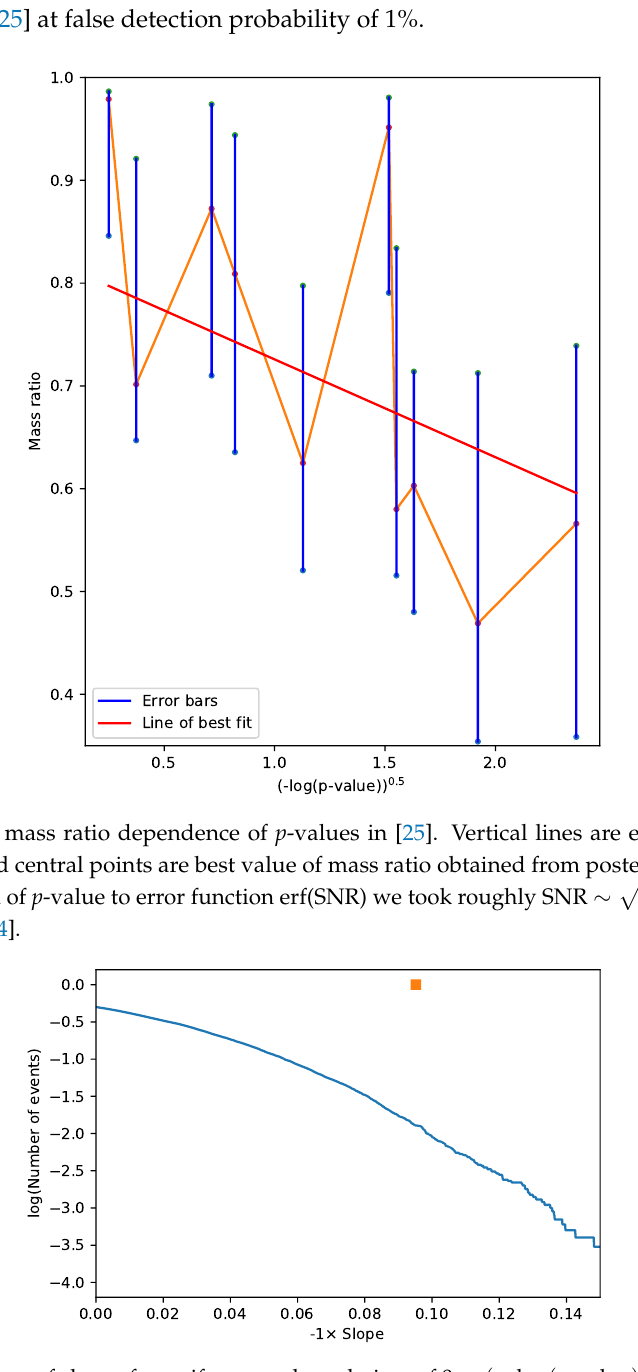
Figure 37. Histogram of slopes for uniform random choices of 0 < ( that only 1.3% of these random realizations, the slope can exceed the observed value